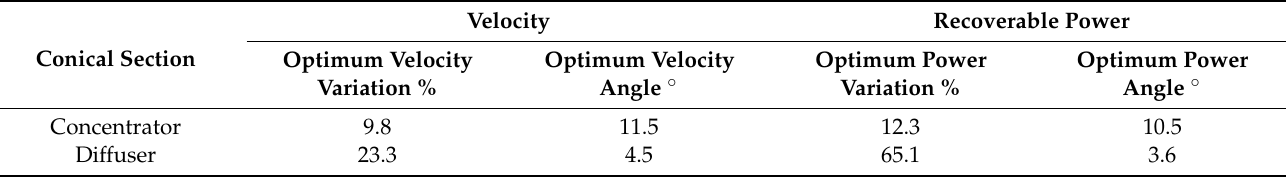
Table 5. Optimum